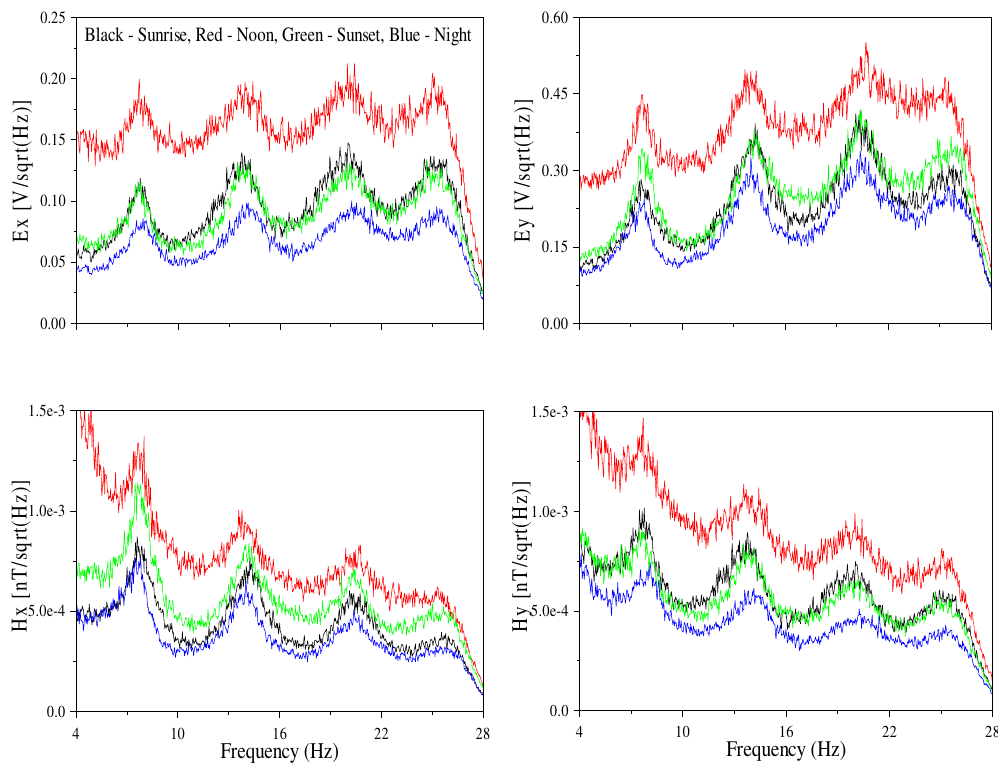
Fig. 3. Amplitude spectral variation in the frequency during the night, sunrise, noon and sunset time for electric and magnetic field com- ponents recorded on 21 May 2006 at Lanka site (lat. 31:02:14.82; long. 78:51:21.31). [Black: sunrise, Red: noon, Green: sunset, Blue: night].